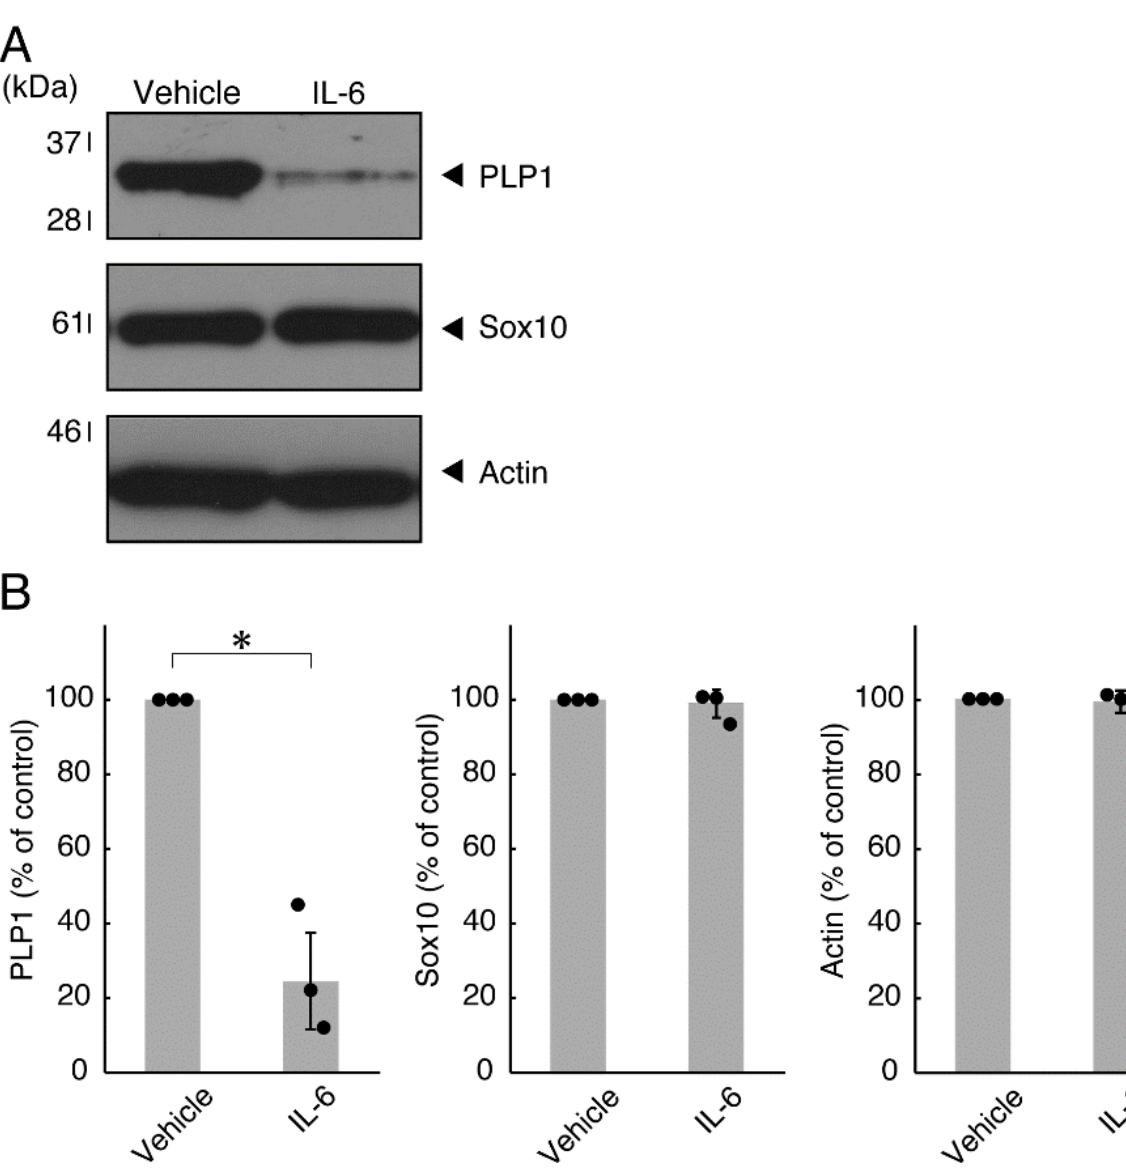
Figure 4. Effects of IL-6 on oligodendroglial cell marker protein expression. ( A , B ) Cells were treated with IL-6 or control vehicles. The PLP1, Sox10, or control actin blot is shown. Immunoreactive band intensities were also compared to be depicted in graphs (*, p < 0.05; n = 3 blots [obtaining one sample each from 3 independent experiments]).